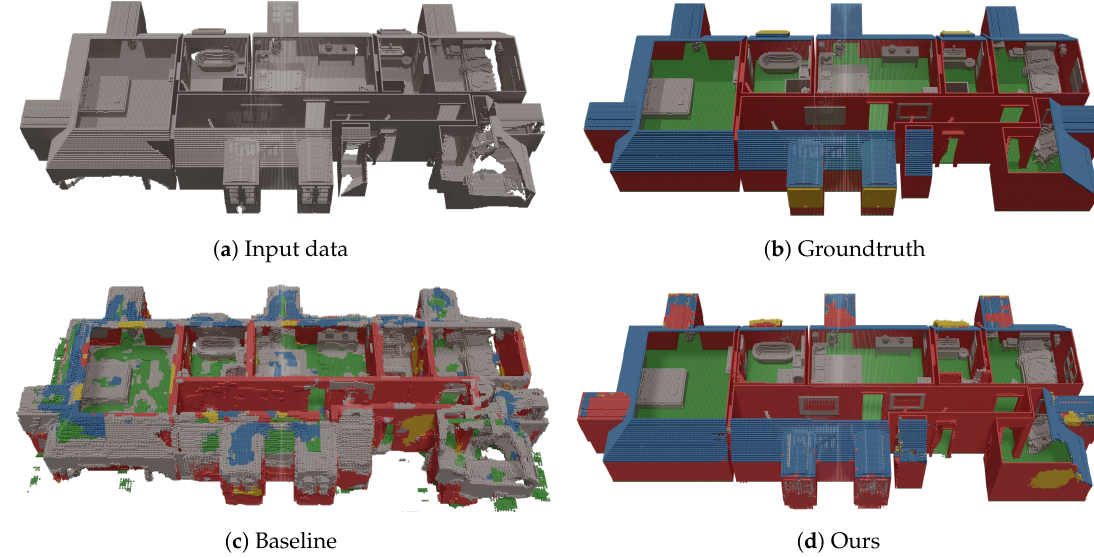
Figure 10. Qualitative evaluation of the baseline ScanComplete network compared to our implementation on a house from the test dataset (first floor).